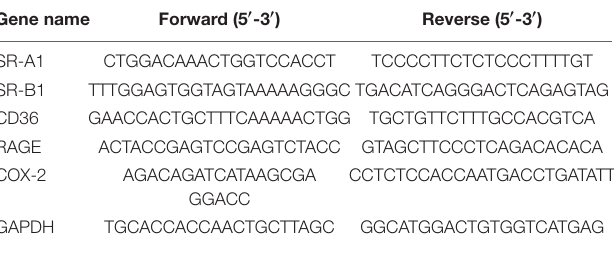
TABLE 1 | Primer sequences for real-time PCR